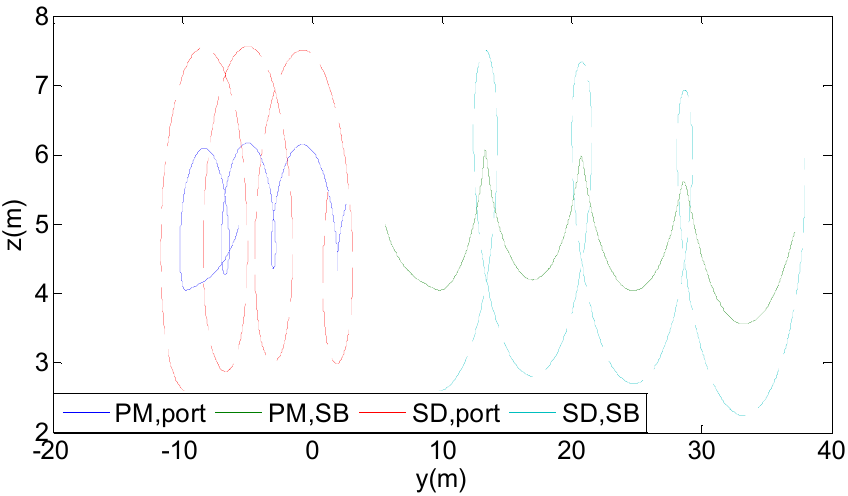
Figure 16. Trajectories of wake vortices in the IGE phase in presence of wind, “PM” refers to primary vortex, “SB” being the starboard vortex, “port” the port vortex, and “SD” the secondary vortex.